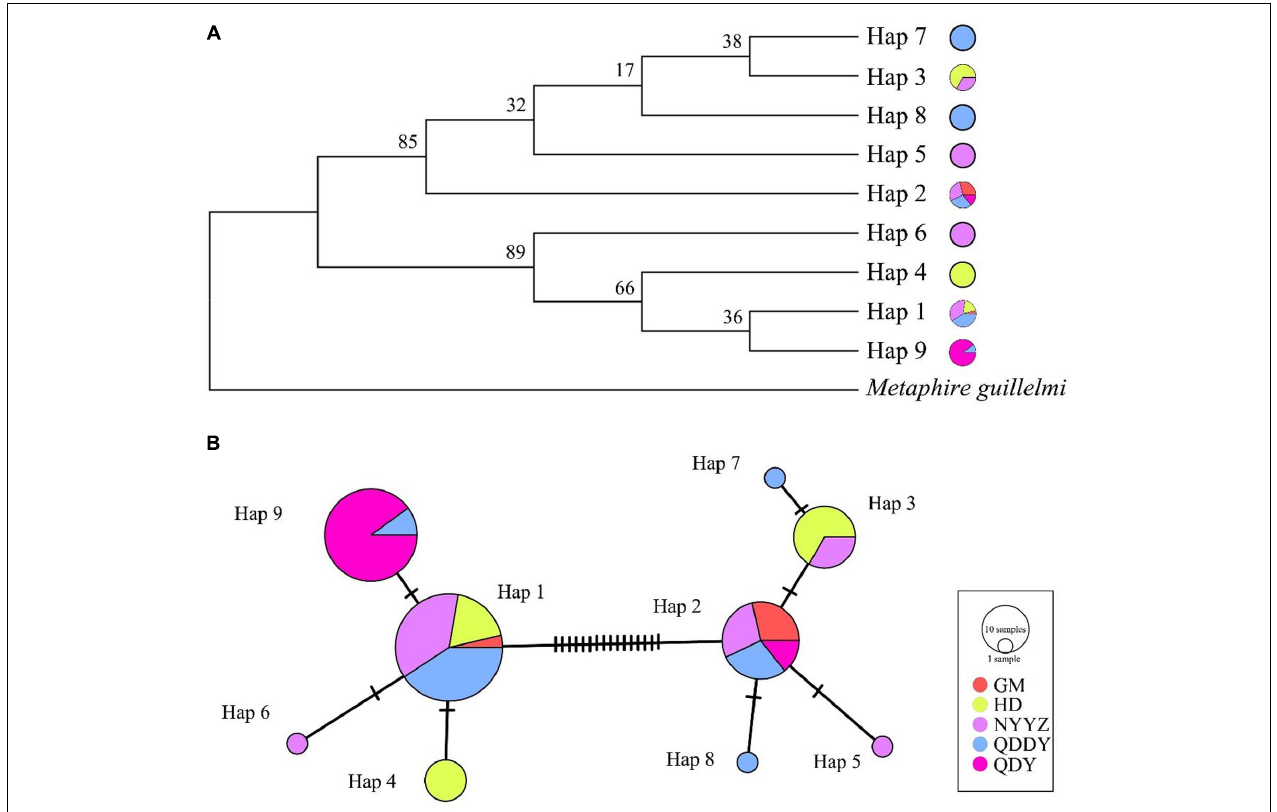
FIGURE 2 | Neighbor-Joining Tree (A) and TCS network (B) based on COI gene. Circle sizes indicate the probability of haplotypes. Different colored in the circles indicate the distribution in different populations, and the oblique lines indicate mutations between